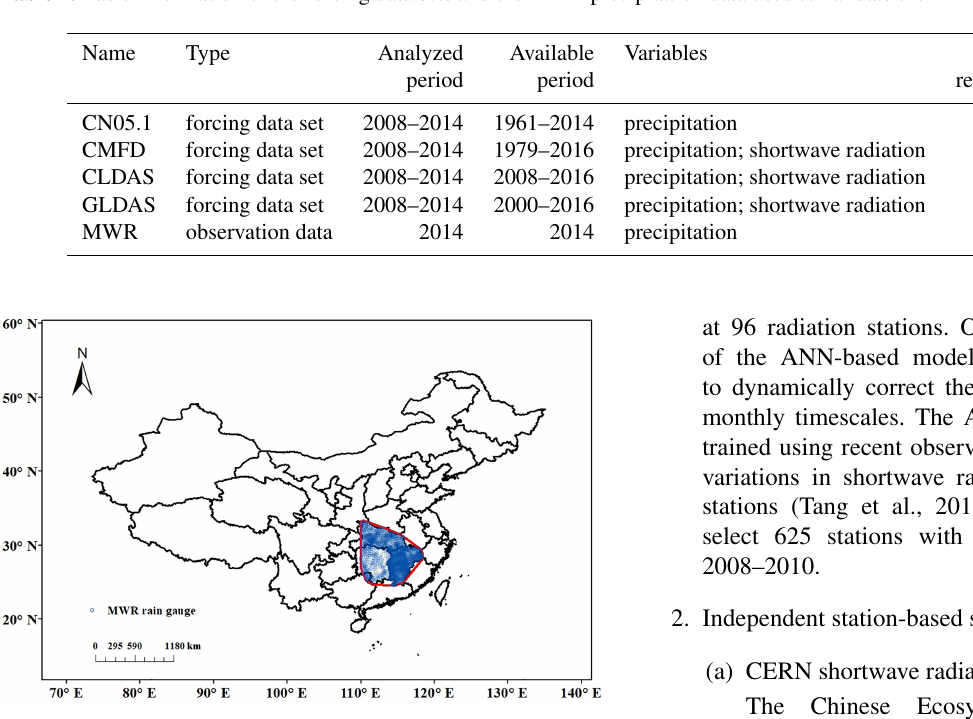
Table 1. Basic information of the forcing data sets and the MWR precipitation data used to validate them.